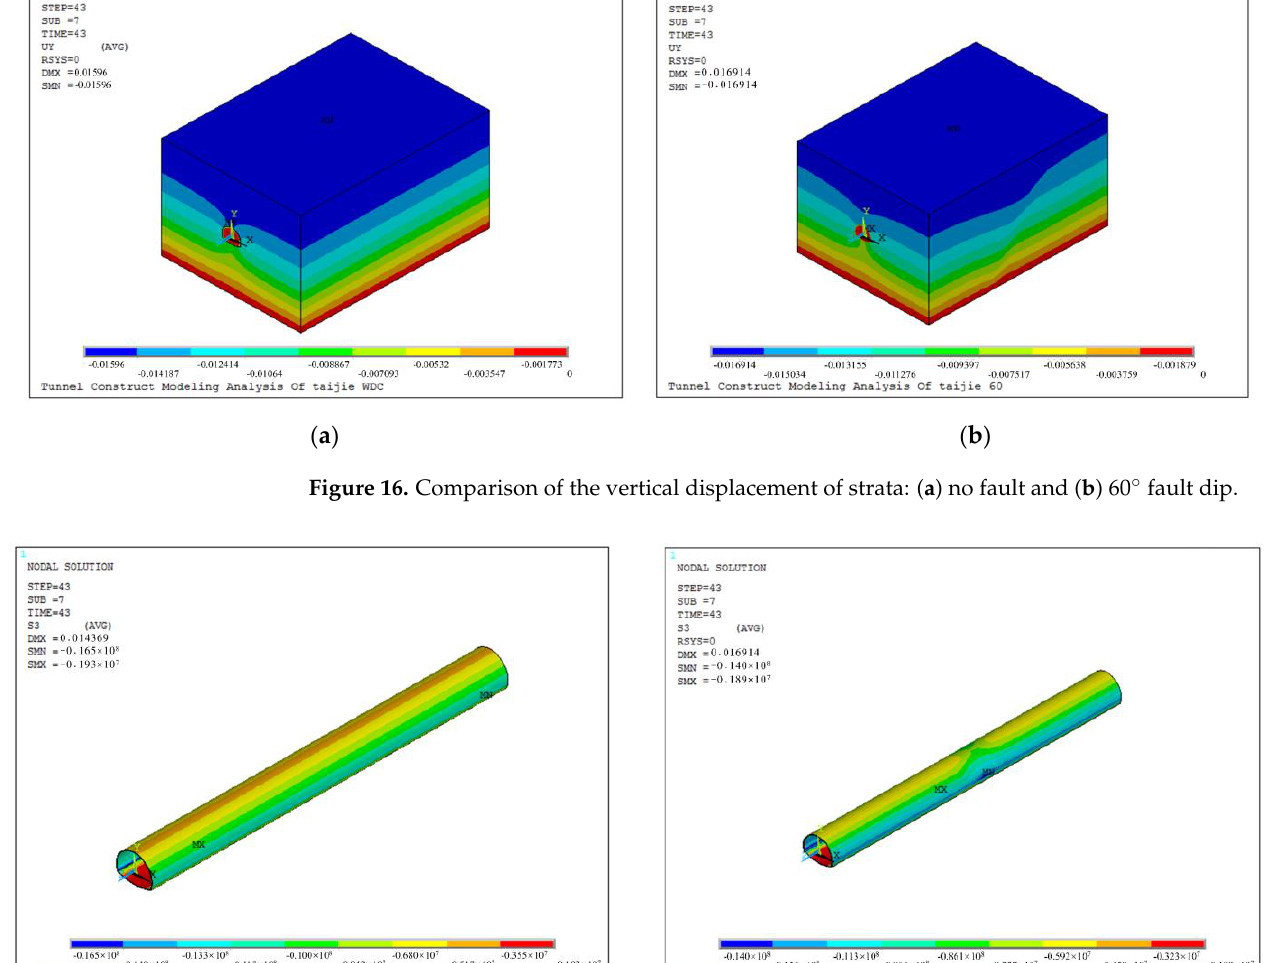
( b ) Figure 15. Comparative analysis of the surrounding rock construction response: ( a ) surrounding rock pressure and ( b ) surrounding rock displacement.